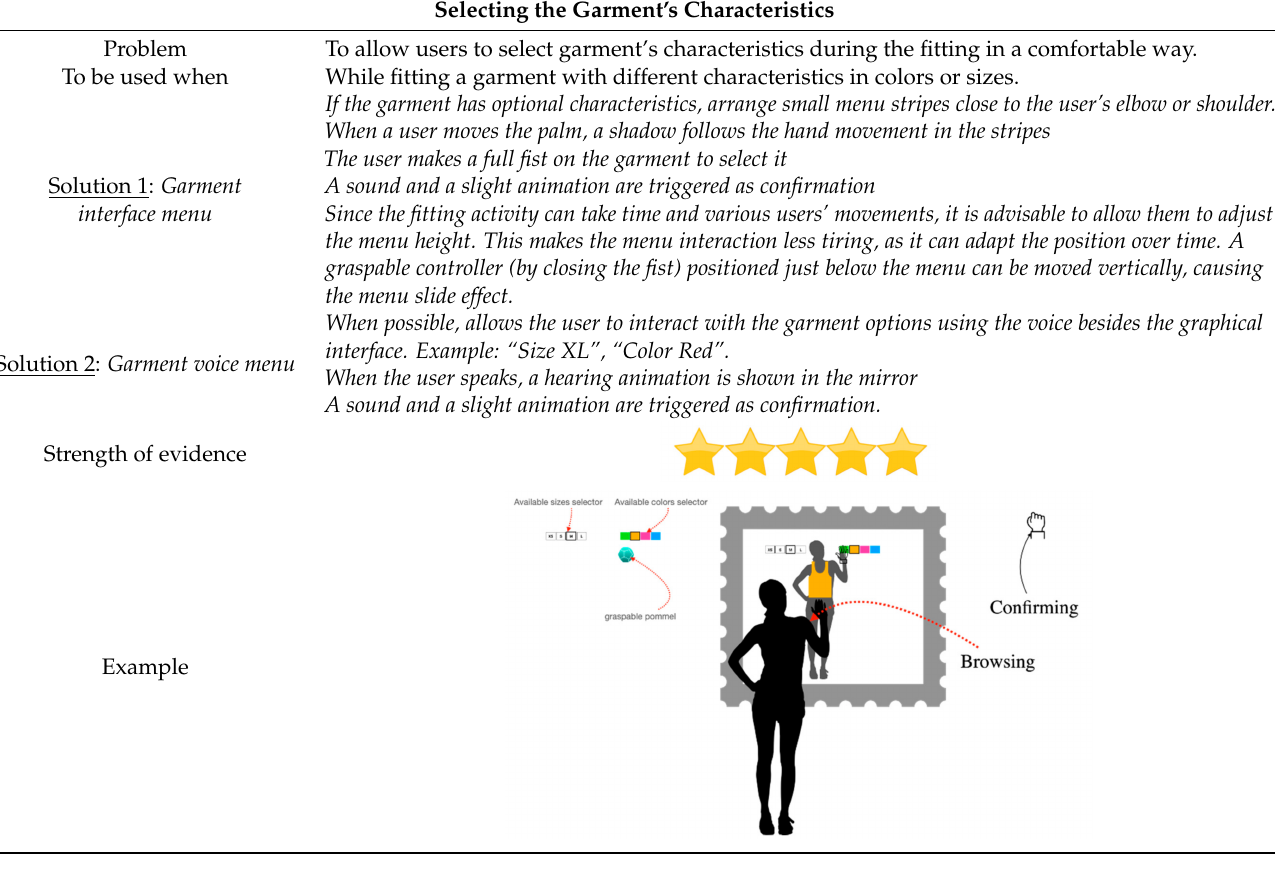
Table 5. Selecting the garment’s characteristics pattern.